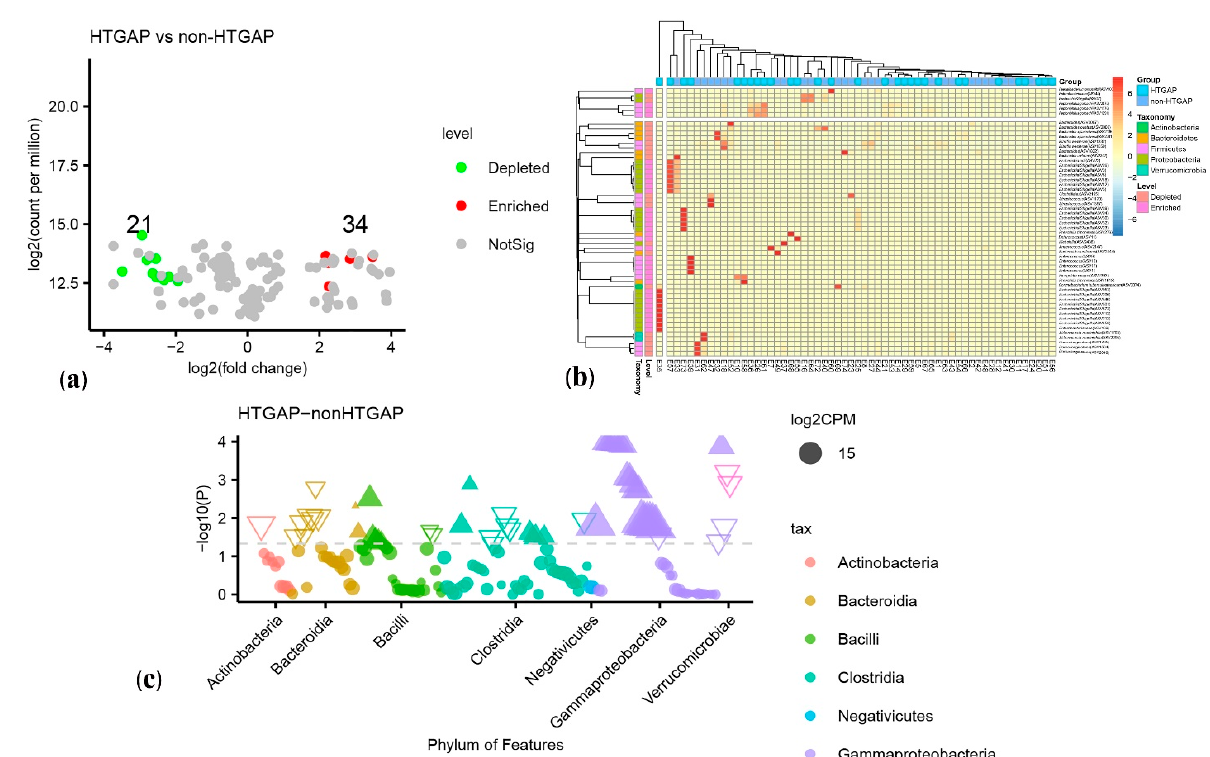
Figure 3. Differential ASVs between HTGAP and non-HTGAP groups. ASV, amplicon sequence variants. ( a ) Volcano plot. Each point represents an ASV, and significantly different ASVs are colored (green = depleted in the non-HTGAP group; red = enriched in the non-HTGAP group; gray = not significantly enriched or depleted). ( b ) Heatmap. Rows represent discriminative ASVs, and columns represent individual samples. Blue represents lower relative abundances, and red represents higher relative abundances. The taxonomic assignment and level of abundance (enriched or depleted) are provided to the left of the heatmap. ( c ) Manhattan plot. The x axis represents the microbial ASV taxonomy at class level ranked by alphabetical order, and y axis represents -log10 (p value). Filled triangles, hollow inverted triangles, and solid circles indicate ASVs enriched, depleted, and without significant difference, respectively. The color of each marker represents the different taxonomic affiliation of the ASVs, and the size corresponds to their relative abundances using log2 transformed CPM values. HTGAP, hypertriglyceridemia-associated acute pancreatitis; ASV, amplicon sequence variants; CPM, count per million.